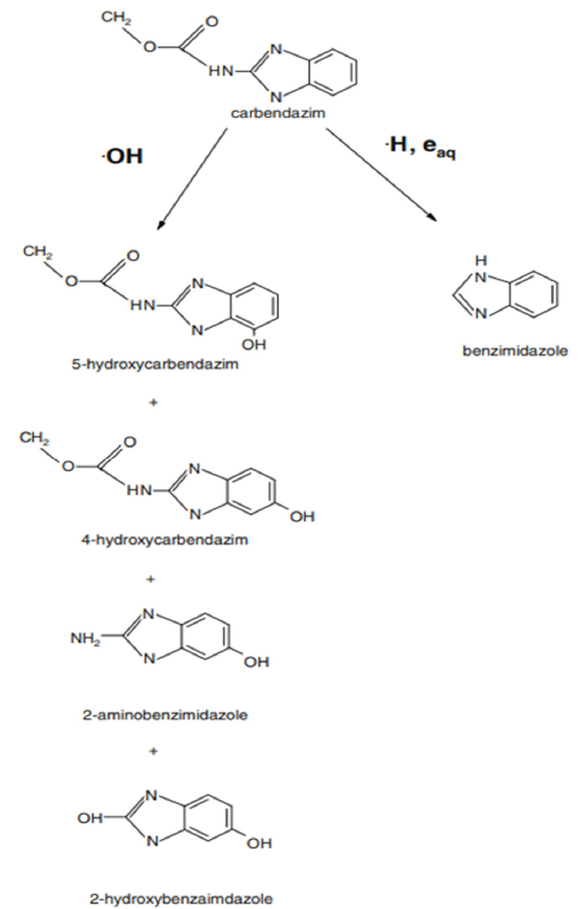
Figure 3. Carbendazim degradation pathway proposed by Bojanowska-Czajka et al. [49].